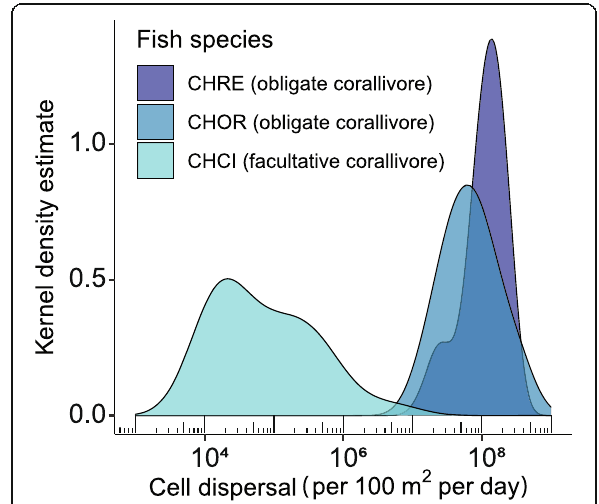
Fig. 4 Corallivores on a South Pacific reef disperse millions of live Symbiodiniaceae cells per 100 m 2 per day. We estimated the number of live Symbiodiniaceae cells dispersed by the obligate corallivores Chaetodon ornatissimus (CHOR) and Chaetodon reticulatus (CHRE) and the facultative corallivore Chaetodon citrinellus (CHCI) per 100 m 2 per day by applying a bootstrap approach (1000 iterations) to the equation T = gSWCF . The estimated number of dispersed Symbiodiniaceae cells ( T ) is the product of five variables: A fish species-specific constant representing the estimated number of egestions in an eight-hour day ( g ); observed fecal pellet sizes in cm ( S ); measured densities of fecal samples in g cm − 1 ( W ); measured densities of Symbiodiniaceae cells g − 1 feces ( C ); and observed fish densities per 100 m 2 ( F ). Due to variation in fish species distributions, most data for CHOR and CHRE were collected on the fore reef, whereas data for CHCI were collected on the back reef. See Table S5 for replication. For data used see Additional file